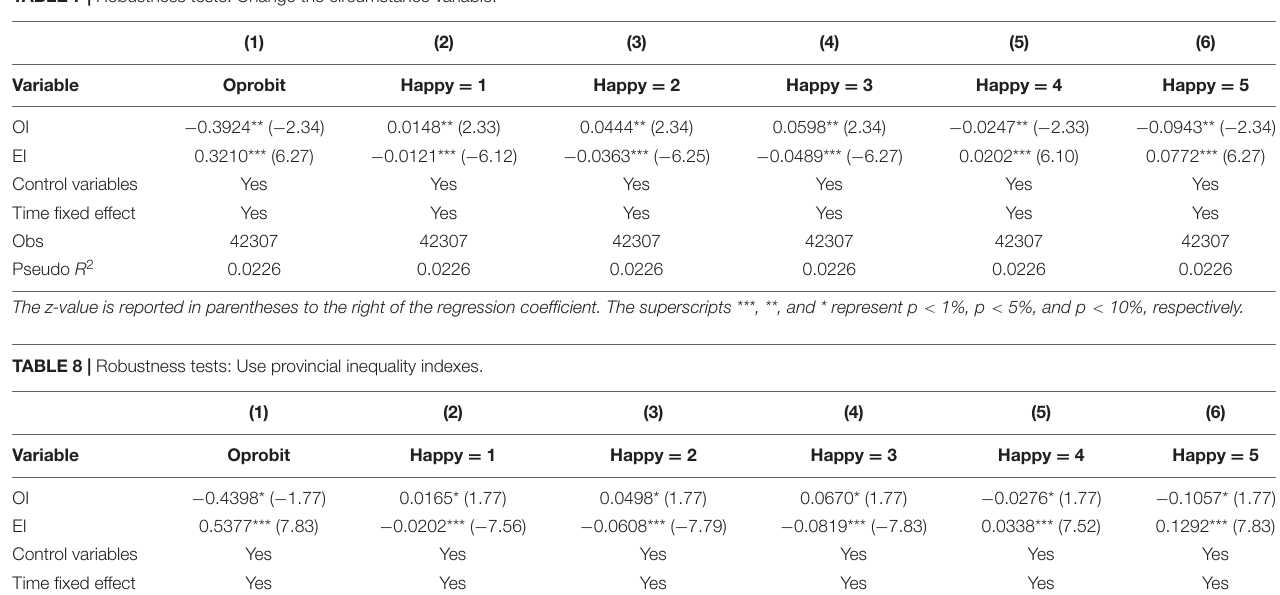
TABLE 7 | Robustness tests: Change the circumstance variable.